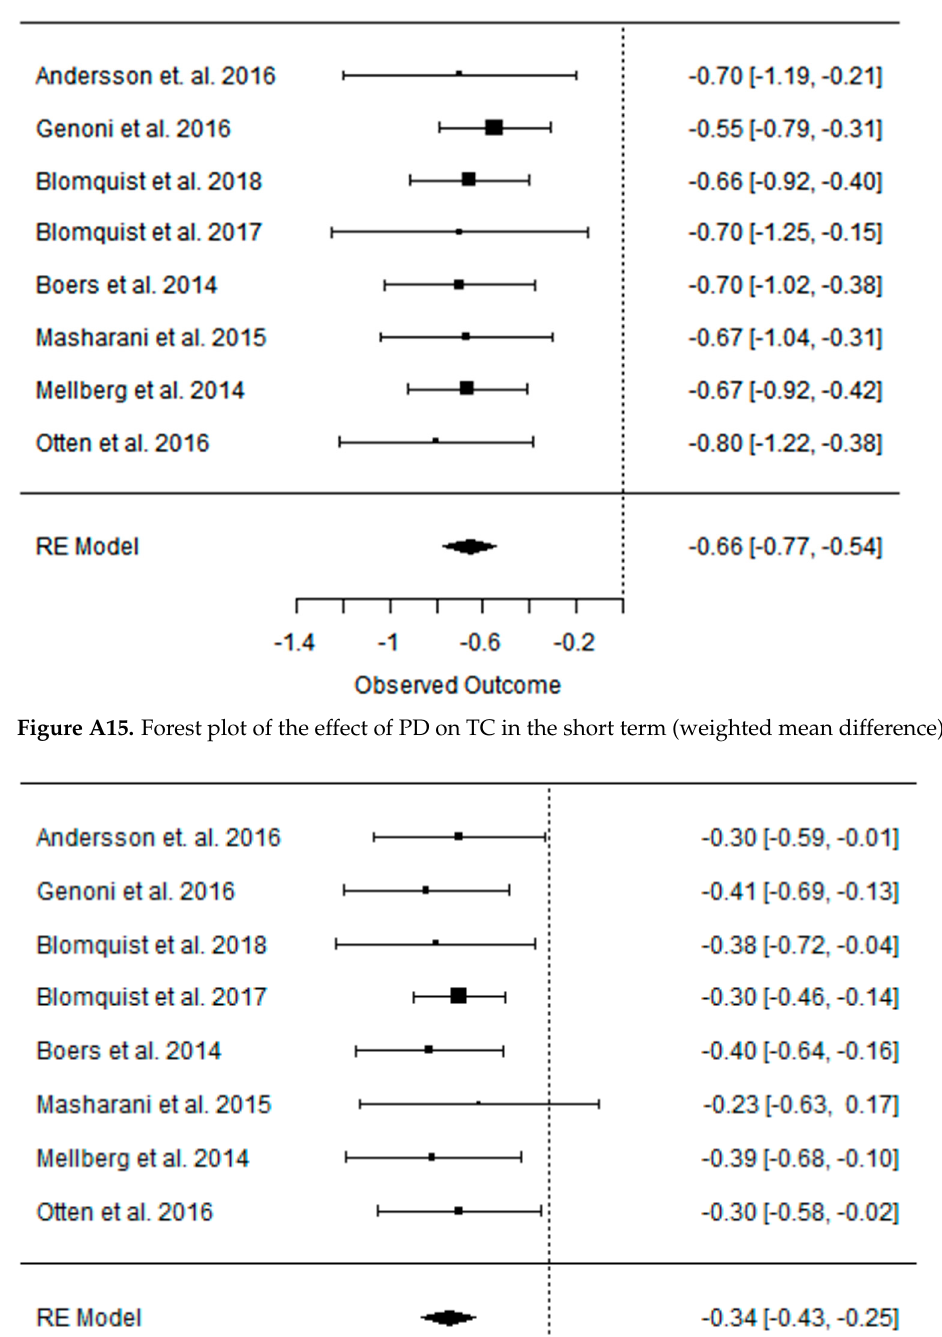
Figure A14. Forest plot of the effect of a PDs on TC in the short term (weighted mean difference).